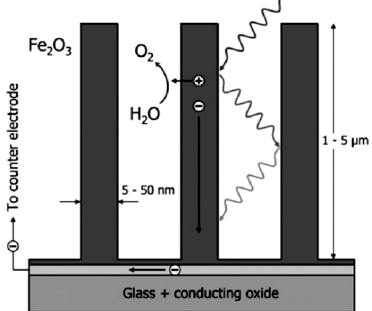
Figure 11. ( a ) 1% W-doped BiVO 4 ; ( b ) W:BiVO 4 homojunction; ( c ) W:BiVO 4 reverse homojunction; and ( d ) gradient-doped W:BiVO 4 ; ( e ) Carrier-separation efficiency ( η sep ) in different applied potential for 1% W-doped BiVO 4 (black triangle), W:BiVO 4 homojunction (red inverted triangle), W:BiVO 4 reverse homojunction (green circle), and gradient-doped W:BiVO 4 (blue square). Reprinted with permission from ref. [38]. Copyright 2018. Nature.